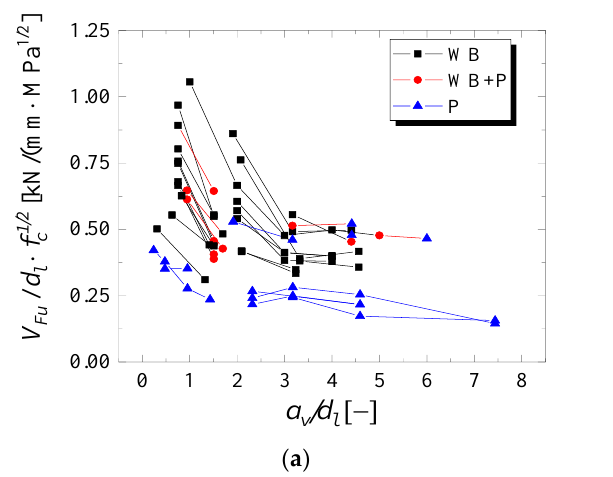
Figure 8. ( a ) Normalized sectional shear achieved in the tests as a function of ( a ) shear slenderness a v / d l and ( b ) change in the cracking pattern and corresponding failure mechanism as a function of the ratio a v / d l (cut views of a set of tests from Reiβen et al. [6]). Source: Adapted from Sousa, Lantsoght and El Debs [24]. Note: WB = wide-beam shear failure (one-way shear); P = punching failure; WB + P = mixed failure mode between one-way shear and punching shear.